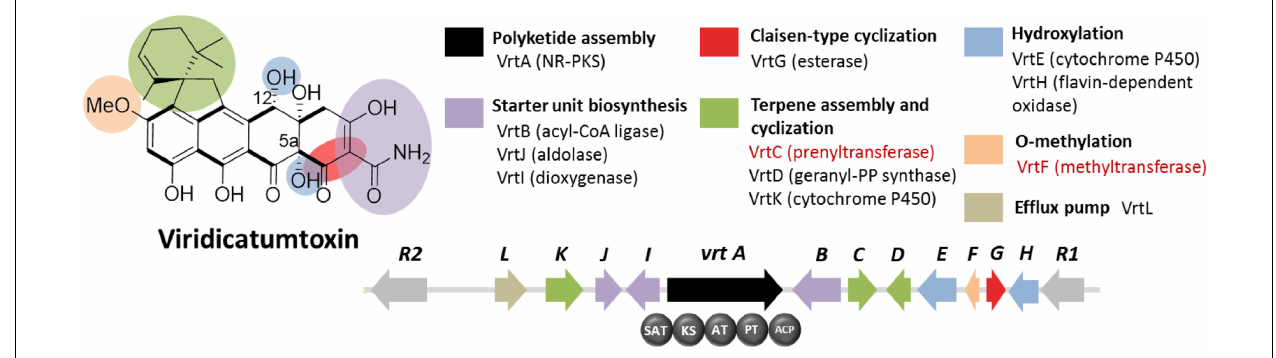
FIGURE 5 |Viridicatumtoxin biosynthetic gene cluster in P. aethiopicum . As with the case for the griseofulvin, the NR-PKS gene vrtA is non-orthologous to PKS genes in P. chrysogenum .The presence of the prenyltransferase gene vrtC and the O -methyltransferase gene vrtF (in red text) led to the identification of the gene cluster.